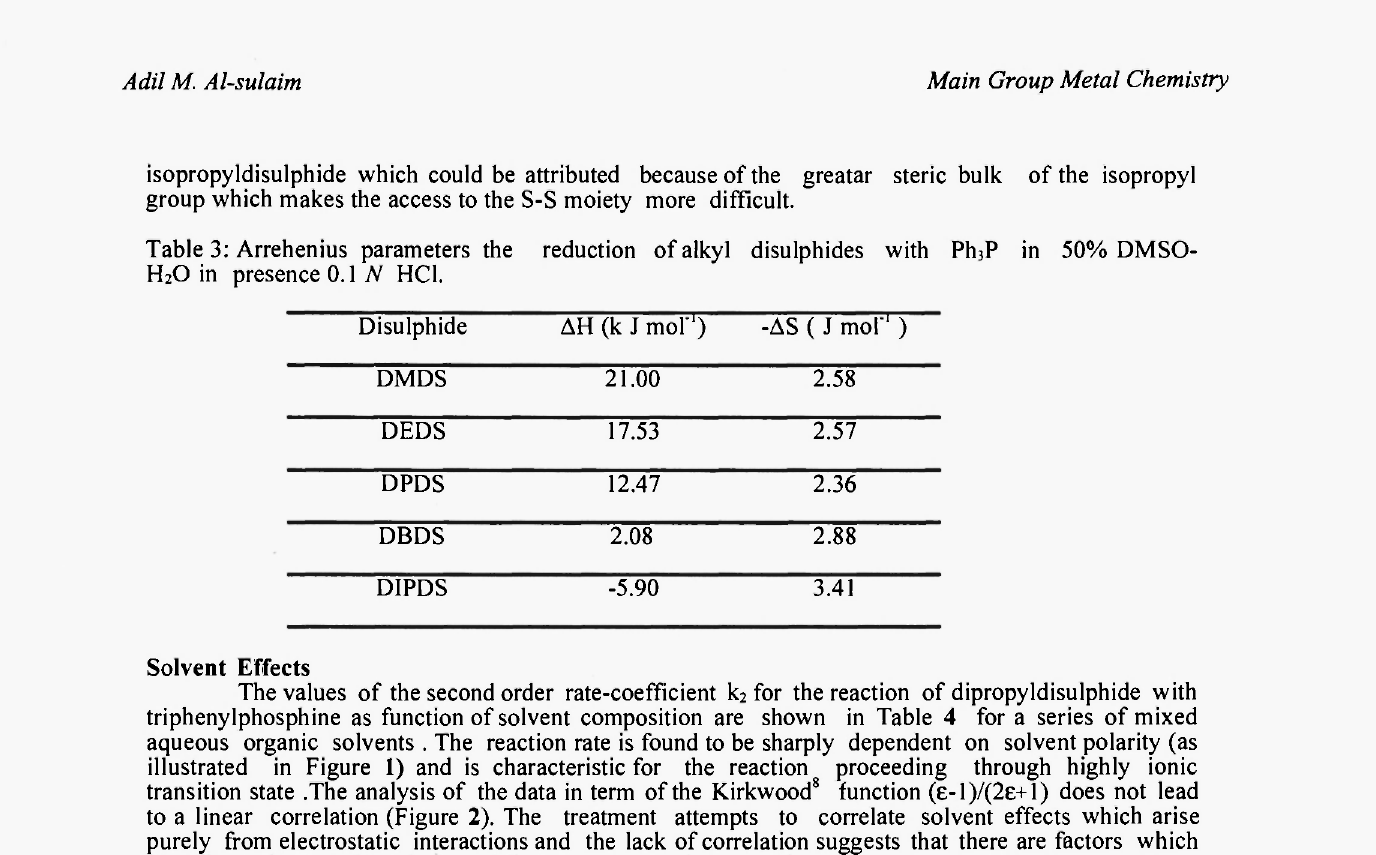
Table 4 : The values of k 2 ( lmol'm" 1 ) for the reduction of dipropyldisulphide with Ph 3 P in aqueous organic solvents in presence of 0.1 NHCl at 40 °C.